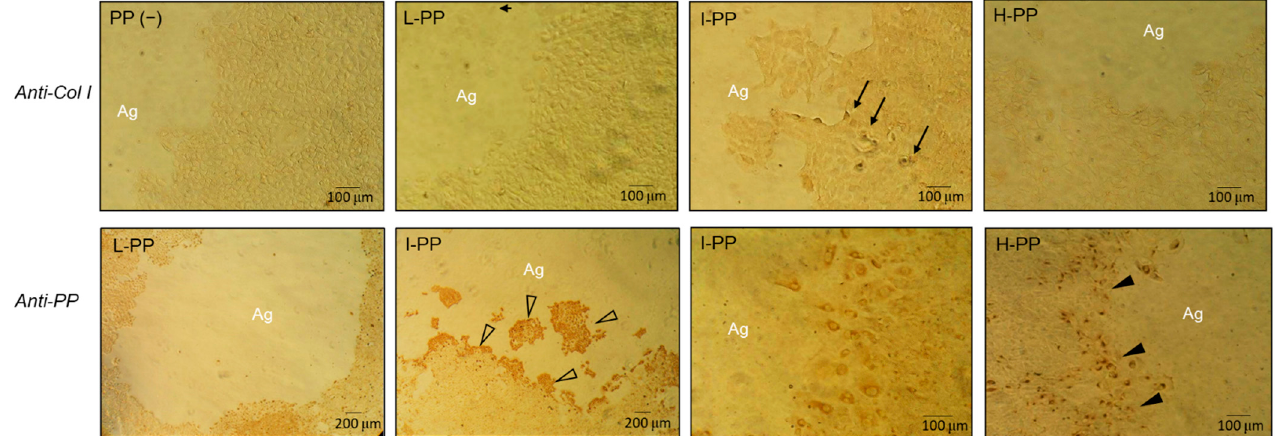
Figure 3. IHC stains of anti-Col I and anti-PP on Day 6. All cells showed insignificant anti-Col I activity except those in I-PP which exhibited antibody activity (indicated by arrows) at the invasion front. Contrarily, all groups showed anti-PP activity. I-PP present the highest immunohistochemistry stain and most stained cells (hollow arrowheads). In group H-PP, only single layer of cells surrounding the agarose present the anti-PP activity (indicated by solid arrowheads). Magnification at 100× and 200×.